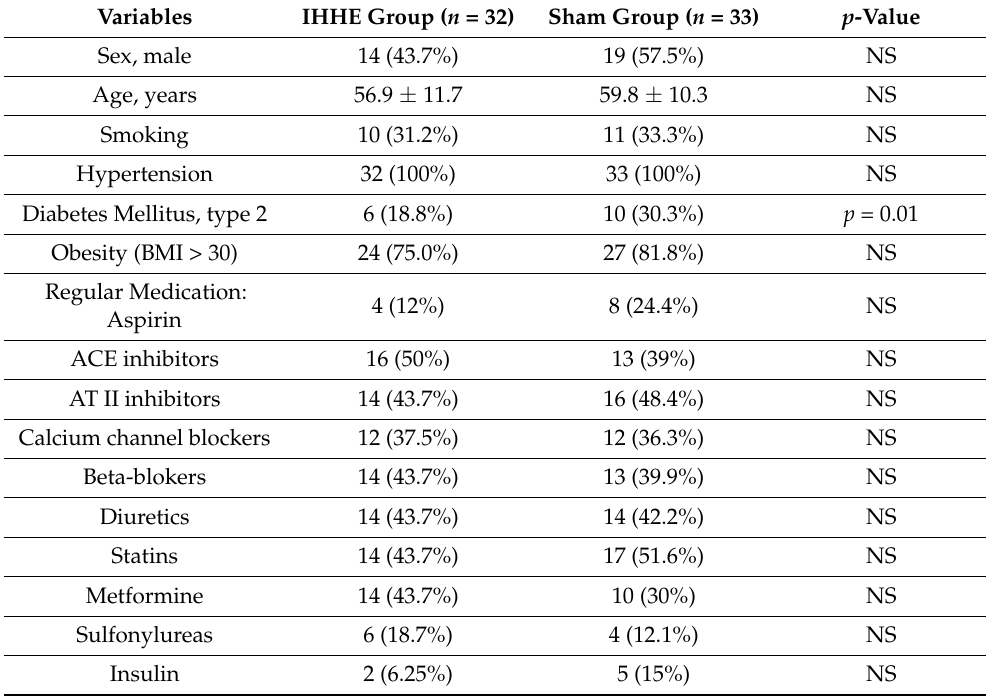
Table 1. Anthropometric and clinical and characteristics of the patients. The data are expressed as mean ± SD or frequencies